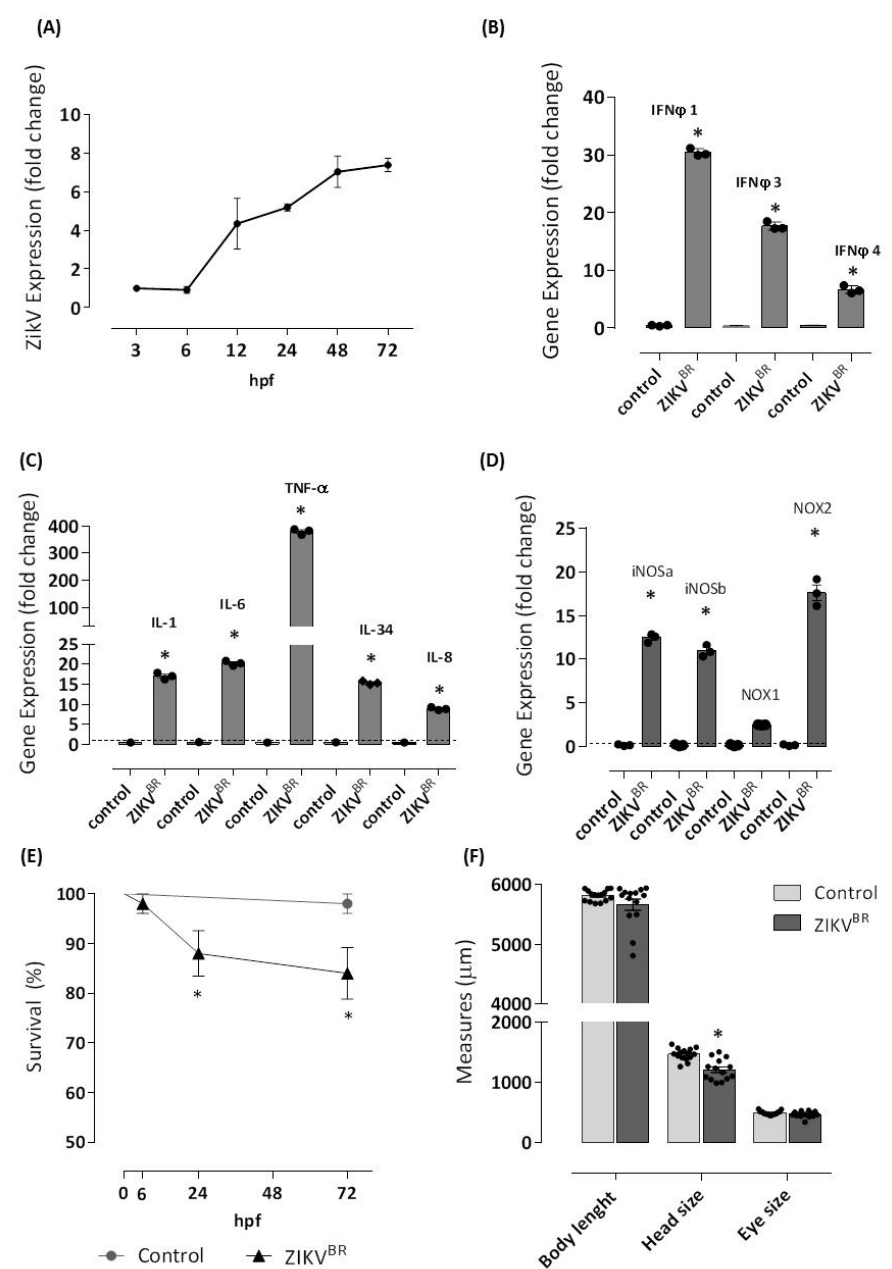
Figure 1. ZIKV infects one-cell stage embryo. The infection ( n = 98) was performed by microinjecting embryos at 0 hpf with approximately 2 or 3 nL of ZIKV BR (1 × 10 7 PFU/mL, 2 a.p.) utilizing a M205C stereomicroscope coupled with an Injectman ® 4 microinjector. Another group ( n = 83) was left without injection and formed the negative control group. Embryos were incubated in E2 0.5 × medium at 28 ◦ C, and viral RNA extracted from entire larvae was used for measurements via real-time quantitative PCR (qRT-PCR) after 3, 6, 12, 24, 48, and 72 hpf of the Zika viral load ( A ).